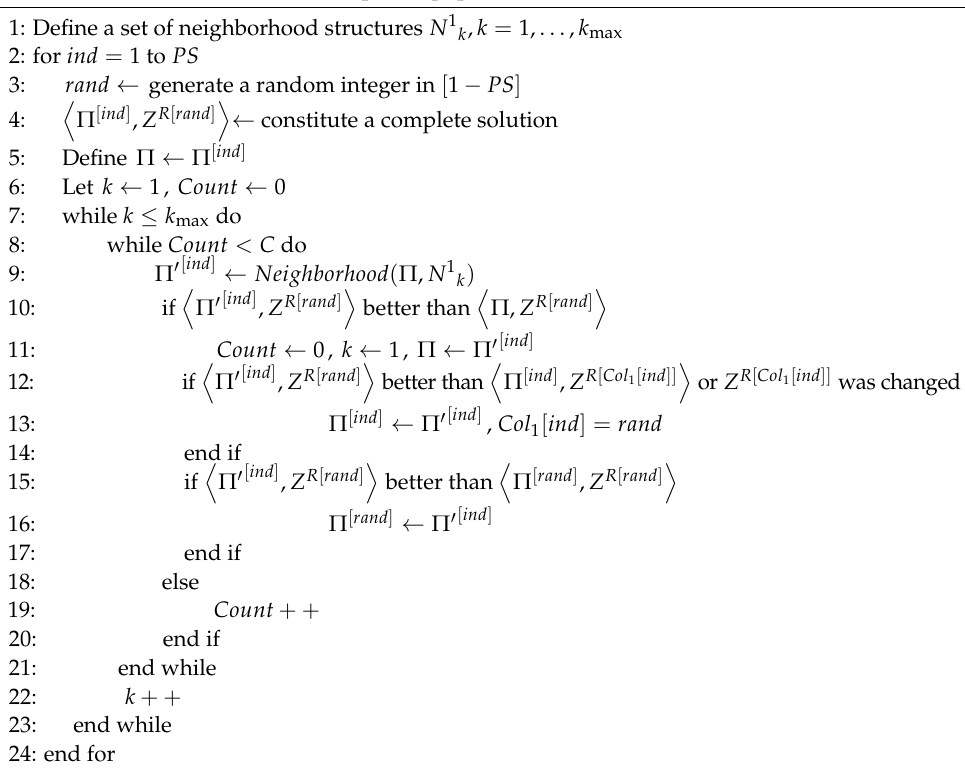
Algorithm 1 Evolution of the lot sequence